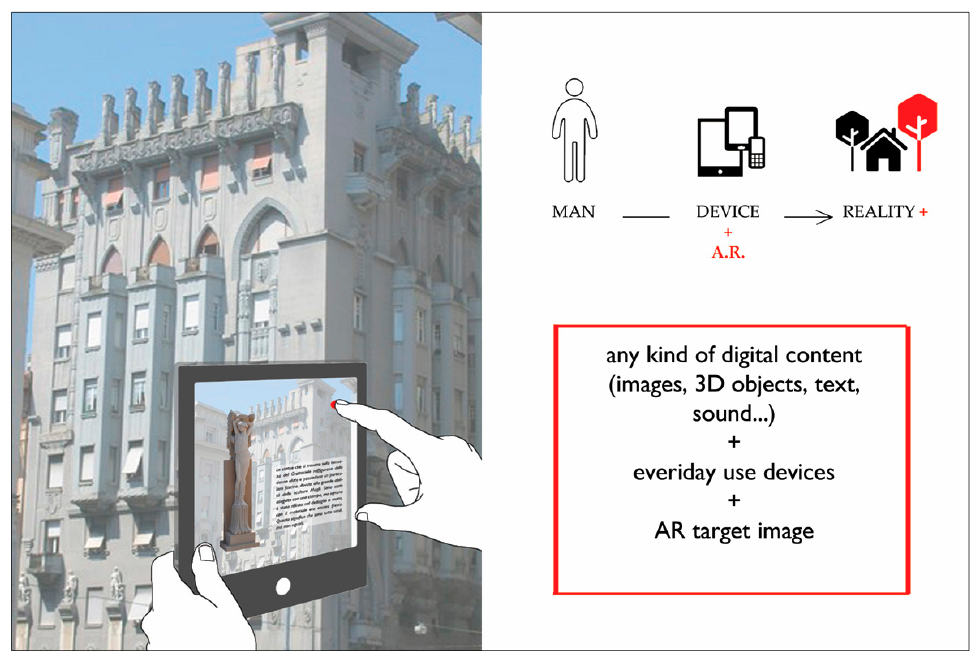
Figure 10. The AR allows you to superimpose digital content to the “natural” vision of the